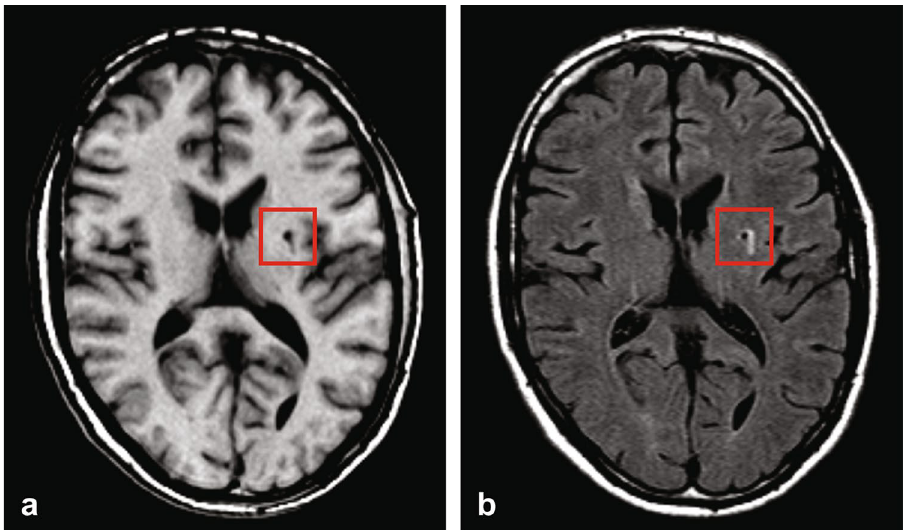
Figure 2. Example transversal image slice of the T1-weighted ( a ) and T2-FLAIR ( b ) acquisitions. A brain infarct can be observed in the right hemisphere next to the basal ganglia, in the red square, as the hypointense region in the T1-weighted image ( a ) and the hypointense region with hyperintense ring in the T2-FLAIR image ( b